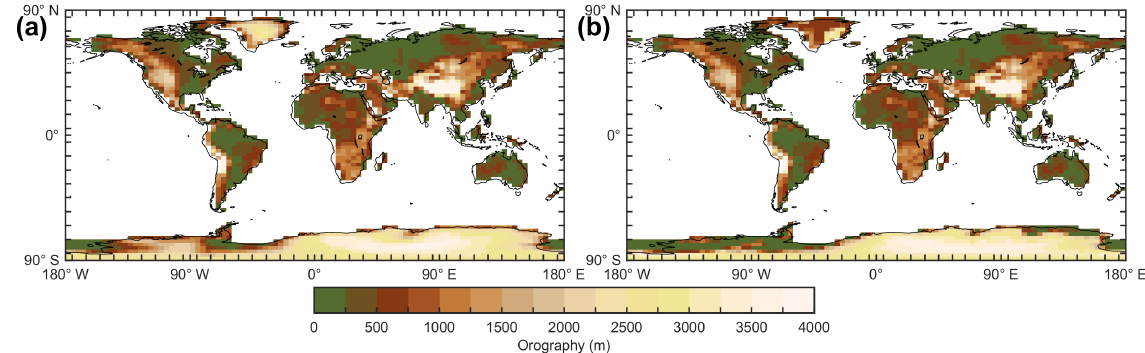
Figure 3. Orography (m) in the two ice sheet configuration ensembles: (a) modice ensemble and (b) lowice ensemble. Differences only occur over Greenland and